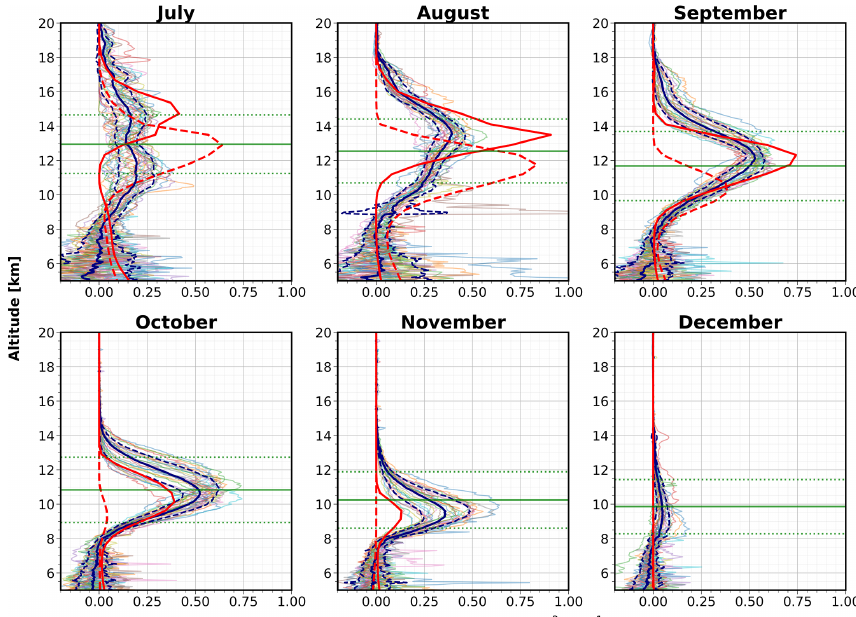
Figure 9. Aerosol extinction coefficient vertical profile averaged longitudinally and over 30–90 ◦ N. Averaged daily CALIOP aerosol ex- tinction coefficient vertical profiles (night retrievals only, fainter lines) with monthly average (bold blue) and monthly average plus or minus standard deviation (solid dashed black lines). UKESM1 SO2 + ash (solid bold red) and SO2only (dashed bold red) simulations with imposed CALIOP minimum retrieval limits and masks. Average tropopause height is shown by the horizontal green line and the average tropopause height ± 1 standard deviation for 2019 is also shown as dotted green